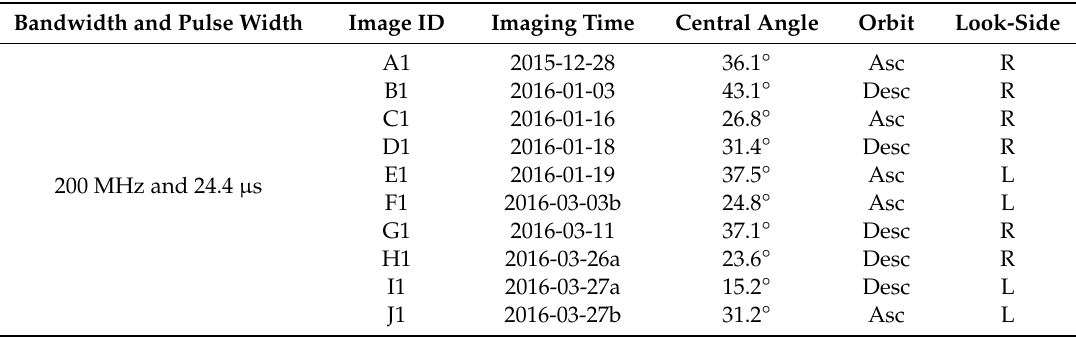
Table 1. Calibration Group A image